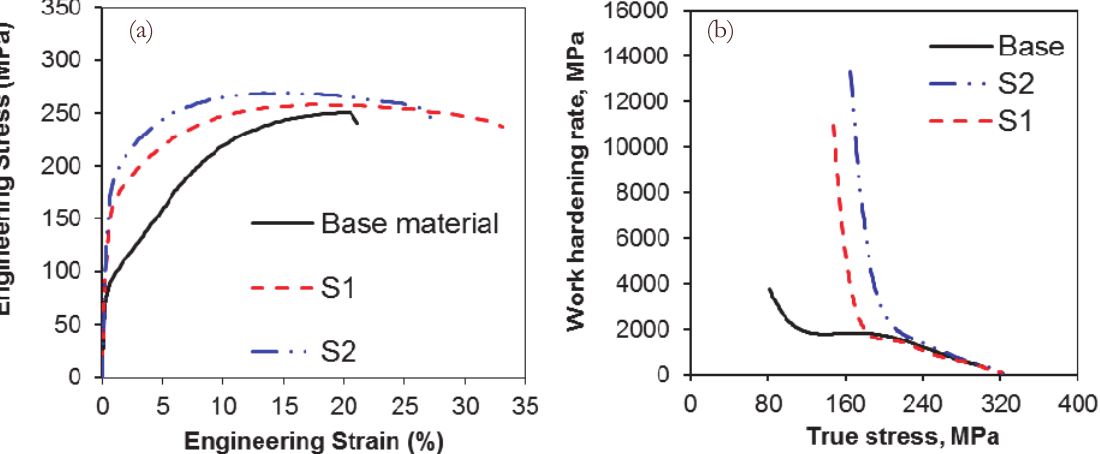
Figure 4: A comparison between base and forged conditions, (a) stress strain curves (b) and K-M plot of the base (as-extruded) and forged AZ31B magnesium alloy during tensile